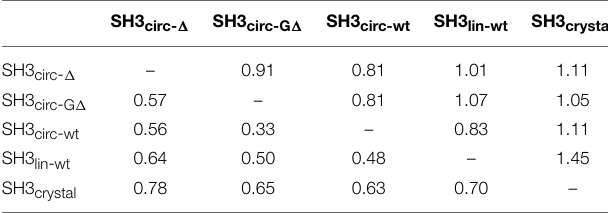
For this comparison, each construct was represented by the mean structure calculated for the ensembles of 20 lowest target function structures. A comparison with the crystal structureofthe(linear)SH3domain(Wuetal.,1995)isalsoincluded.TheRMSDvalues(in Å) were calculated for the backbone heavy atoms; the numbers above the diagonal rep- resent the RMSD values for the whole backbone (residues 137–189), while those below